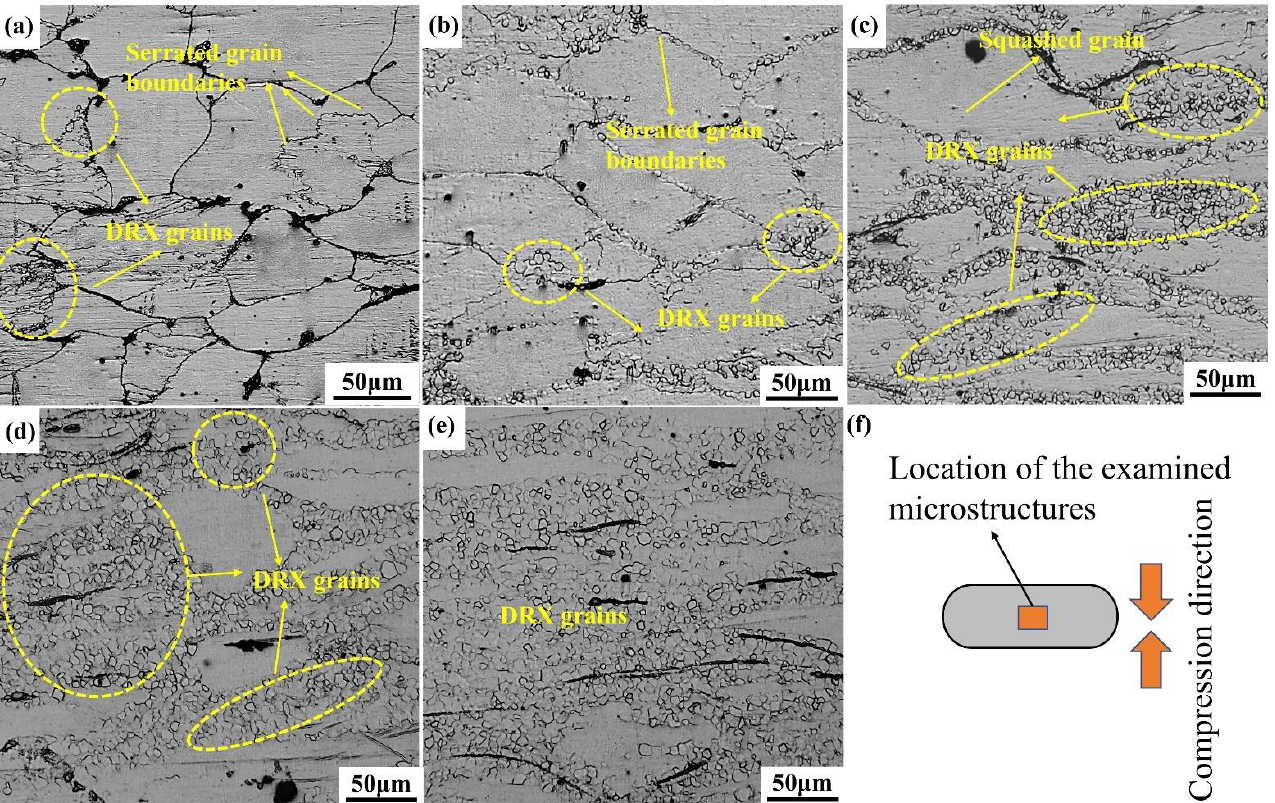
Figure 15. Microstructure of compressed samples with strain rate is 0.02 s −1 at 400 °C: ( a ) ε = 0.1, ( b ) ε = 0.3, ( c ) ε = 0.5, ( d ) ε = 0.7, ( e ) ε = 0.9, ( f ) Schematic diagram of the location of the examined microstructures.